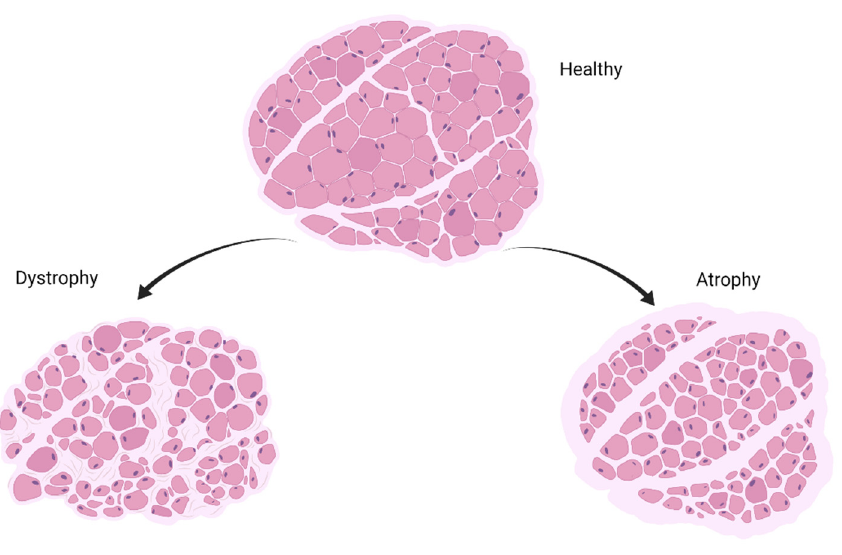
Figure 3. Muscle cross-sections of three conditions (healthy, dystrophic, and atrophic muscle) (created with BioRender.com (accessed on 28 October 2021)).